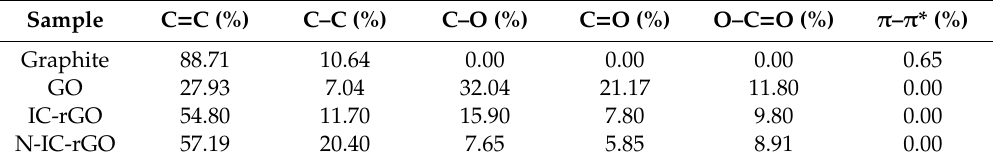
Table 1. Proportion of functional groups calculated from the high-resolution C1s spectra.